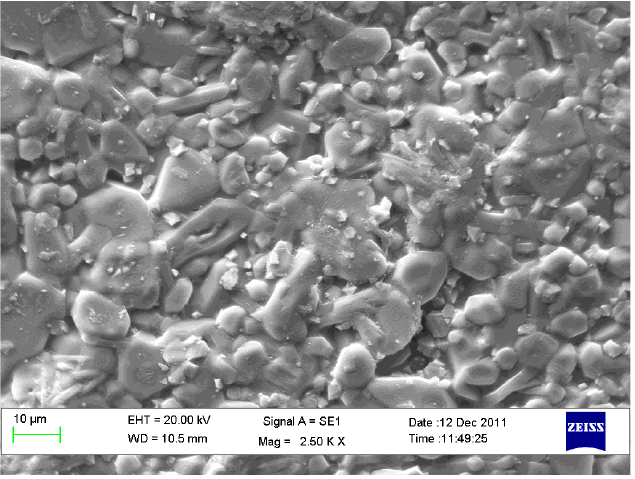
Figure 4. Scanning Electron Microscope (SEM) micrography (2500×) of the surface of sample made with olivine fired at 1300 °C.